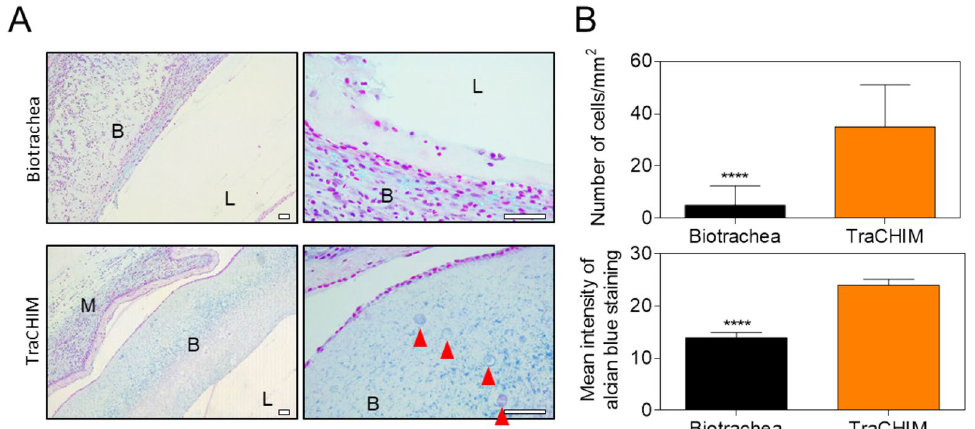
Figure 4. ( A ) Alcian blue-stained histological images of tissues harvested from the biotrachea- and TraCHIM- implanted groups. B, L, and M: bioink, lumen, and membrane, respectively. Red arrows indicate encapsulated chondrocytes. Scale bars, 50 μm. ( B ) Numbers of chondrocytes per unit area, and the mean intensity of alcian blue staining, in the histology images. Bars reflect the mean ± standard deviation. **** p <